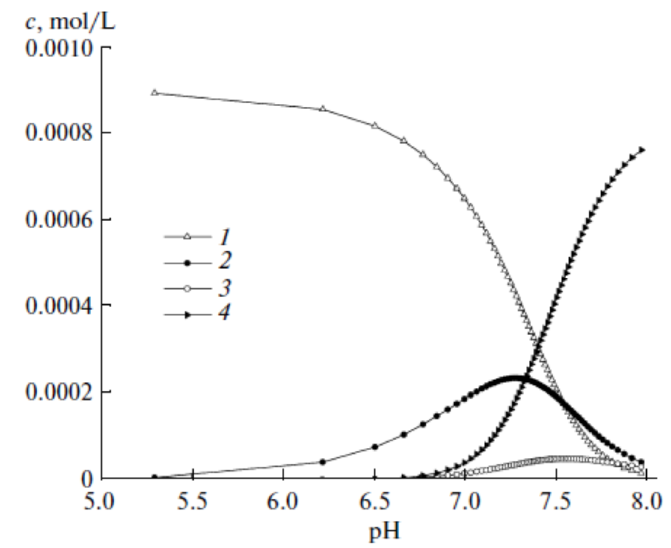
Figure 4. Equilibrium speciation distribution vs. pH for the Lu(NO 3 ) 3 system on the background of + , (4) Lu(OH) 3 + , (2) Lu(OH) 2 + , (3) Lu(OH) 0.1M KNO 3 : (1) Lu 3+ , (2) Lu(OH) 2+ , (3) Lu(OH) 2+ , (4) Lu(OH) 3 —with permission from [36]. 0.1M KNO 3 : (1) Lu 2 3 —with permission from